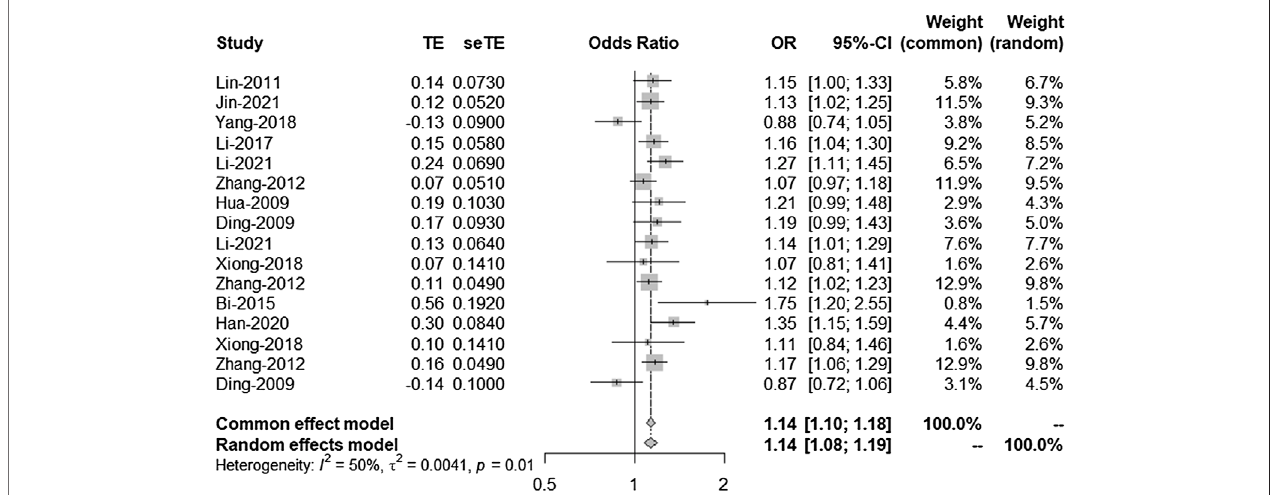
FIGURE 2 | Random-effects meta-analysis of the association between the three single-nucleotide polymorphisms (SNPs; rs2383207, rs2383206, and rs10757278) and ischemic stroke (IS). CI, con fi dence interval; OR, odds ratios.